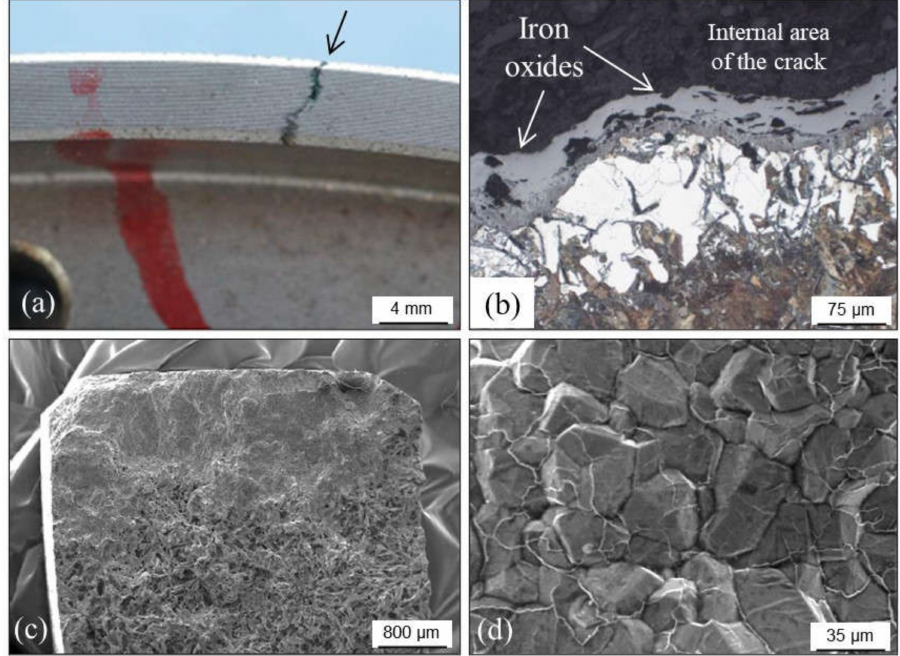
Figure 61. Hot tear found in a grey iron casting ( a ). Metallographic view of the internal surface of a crack ( b ). SEM view of the internal surface of a hot tear ( c , d